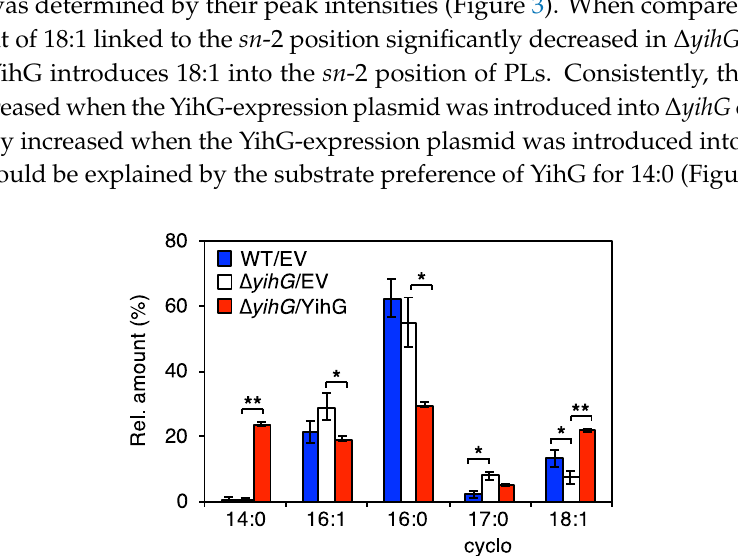
Figure 3. Effects of yihG disruption on the fatty acyl group at the sn -2 position of PLs. Total PL extracts were hydrolyzed by PLA2, and the resulting fatty acids were analyzed by GC–MS. The graph shows the relative amounts of the fatty acids from wild-type cells harboring the pBAD-Cm R empty vector (WT/EV, blue) and ∆ yihG cells harboring the pBAD-Cm R empty vector ( ∆ yihG /EV, white) or pBAD/ yihG-his 6 ( ∆ yihG /YihG, red). Data are shown as the mean ± SD ( n = 3). The cyclopropane derivative of 16:1 is indicated as 17:0cyclo. Statistical analysis was performed using Welch’s t -test: *, p < 0.05; **, p < 0.01.